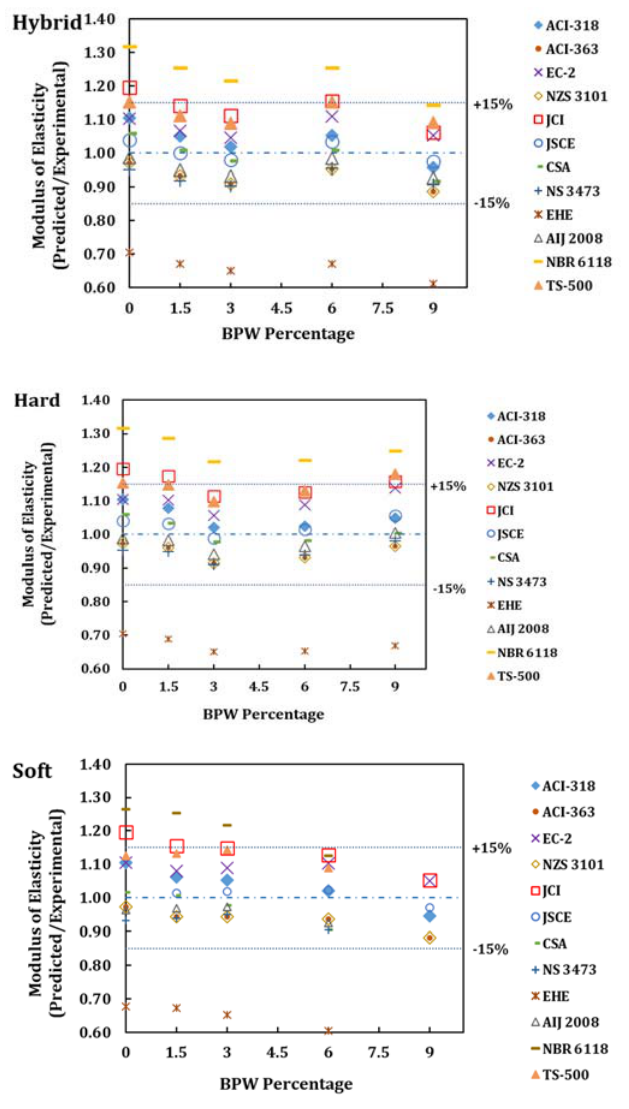
Figure 17. The ratio of predicted modulus of elasticity by the compressive strength from different design codes for conventional concrete and experimental modulus of elasticity results [16,68,71–74,78–83].